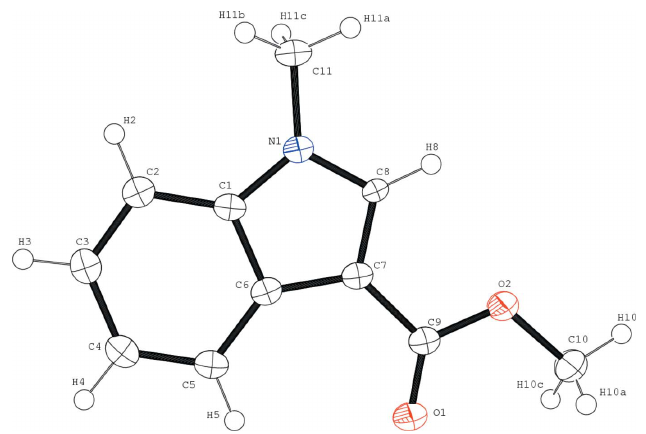
Figure 1 The molecular structure of the title compound, showing the atom- numbering scheme and displacement ellipsoids drawn at the 50% probability level.